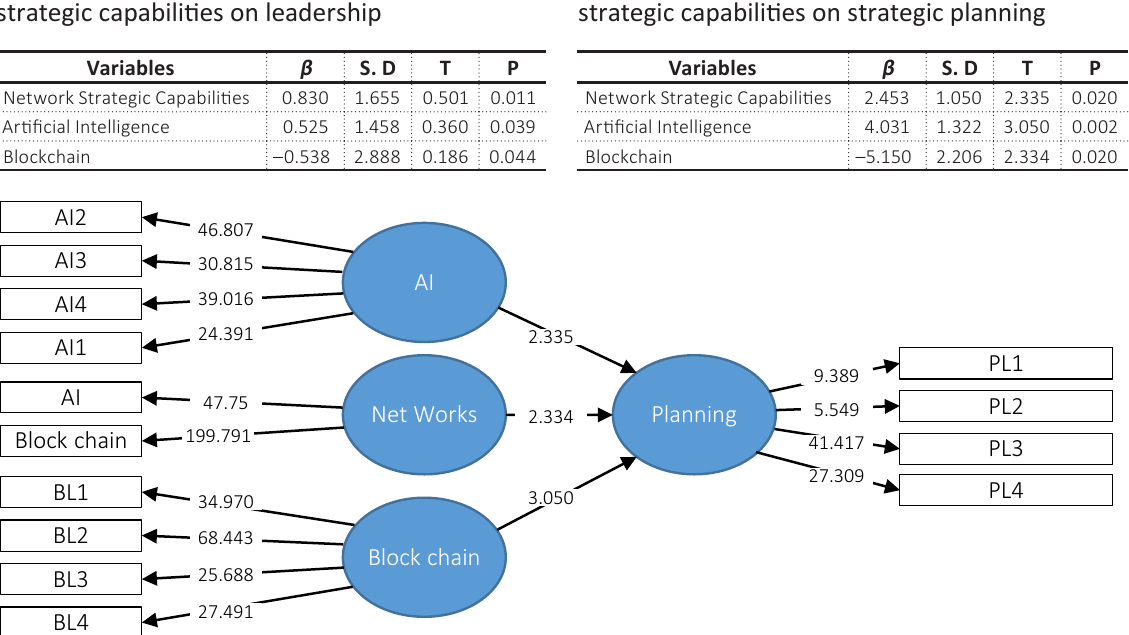
Table 7. Path analysis to employ networks